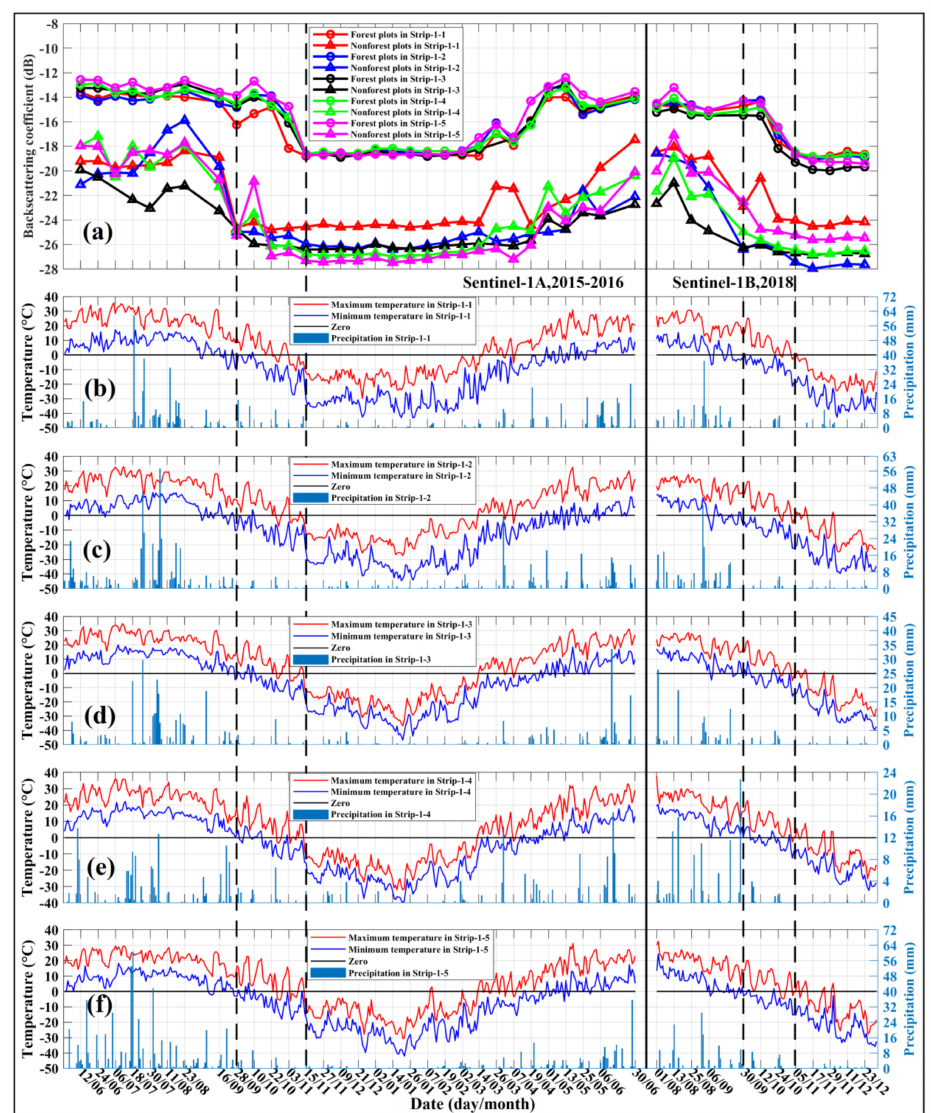
Figure 7. Time series of VH backscattering coe ffi cients on the type I and type VII sampling plots of the first group and corresponding daily temperatures and amount of precipitation within scenes from Strip-1-1 to Strip-1-5: ( a ) Backscattering coe ffi cients of forest plots (in red) and non-forest plots (in blue); ( b – f ) are daily temperatures and amount of precipitations within scenes from Strip-1-1 to Strip-1-5,